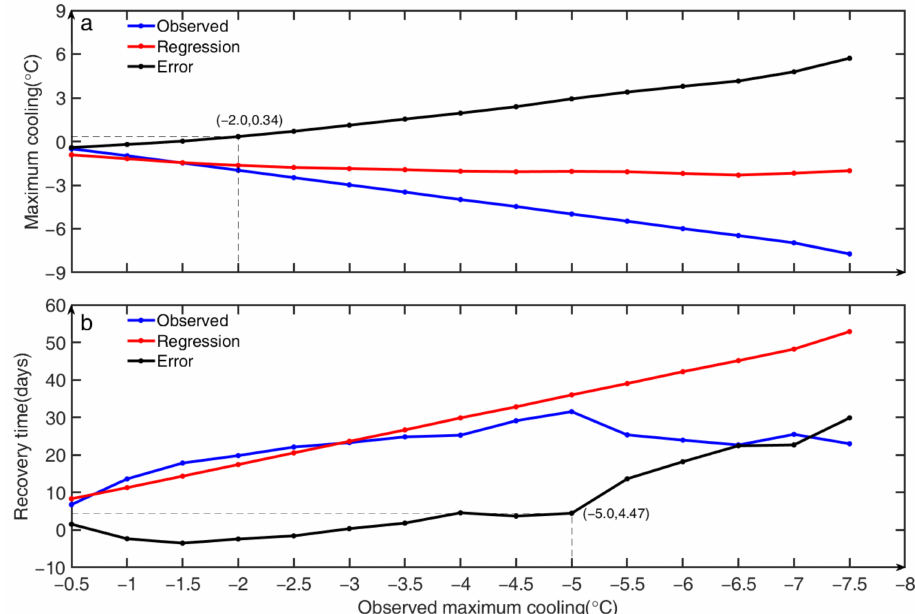
Figure 10. Comparison of maximum cooling ( a ) and recovery time ( b ) between observation and the regressed value in each 0.5 ◦ C bin of observed maximum